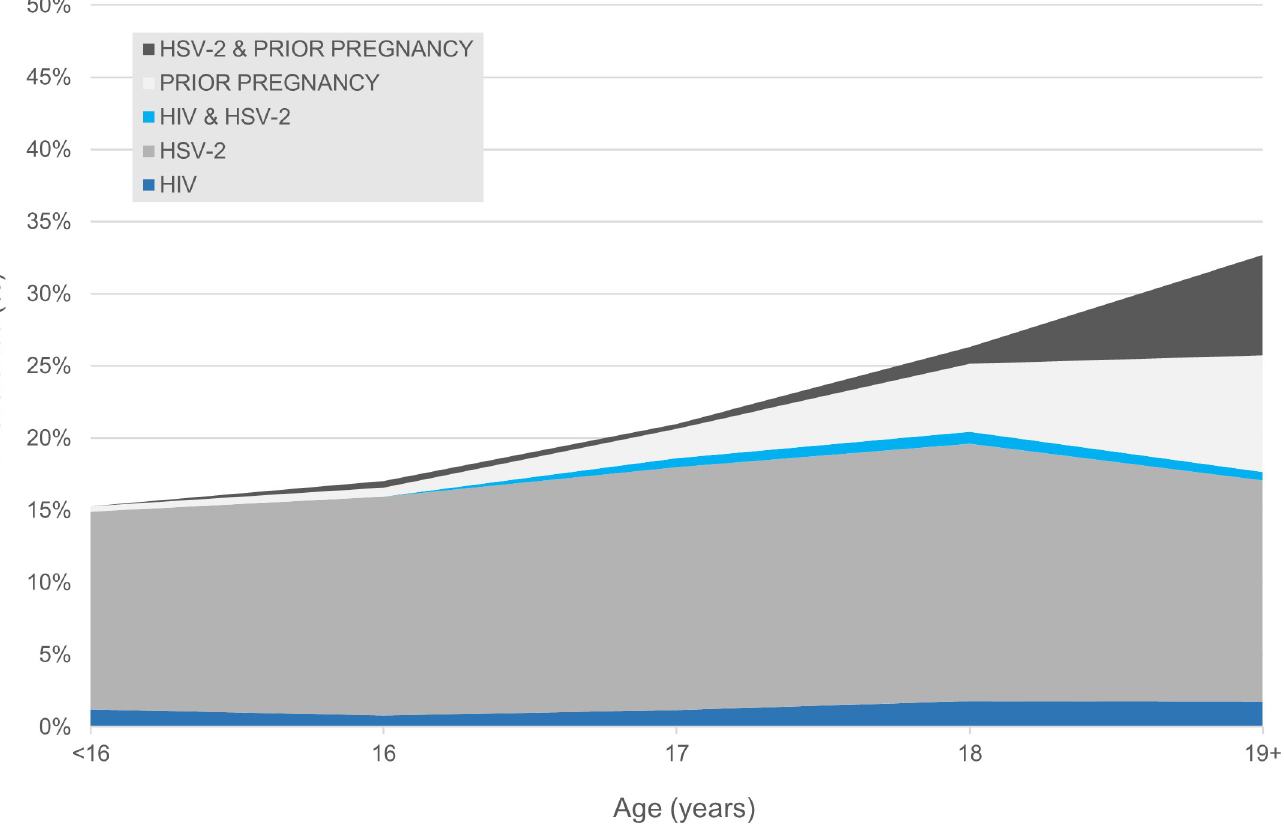
Fig 2. Combined baseline prevalence of HIV, HSV-2, and history of pregnancy among CCG girls ( n = 3,998). CCG, Cups or Cash for Girls Trial; HIV, human immunodeficiency virus; HSV-2, herpes simplex virus type 2.